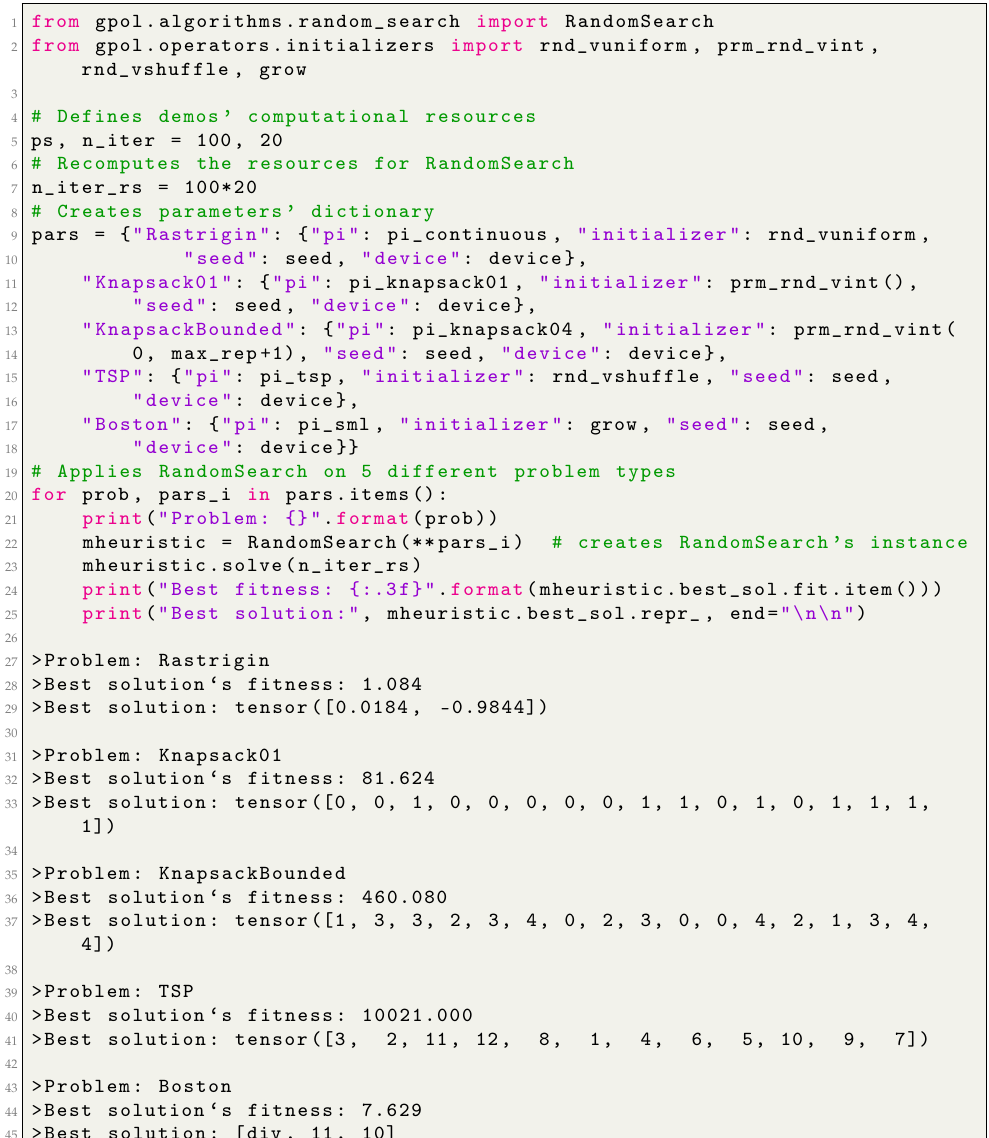
Figure A5. Examples of RandomSearch being used to solve various